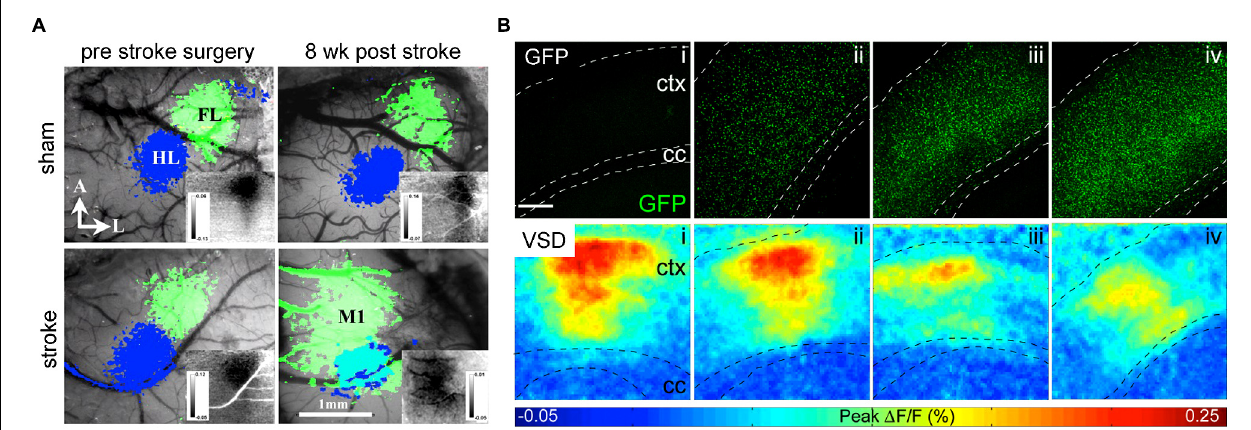
FIGURE 4 |VSD imaging detects macroscopic changes in functional networks after stroke and implantation of NSCs. (A) Changes of the functional representation of the forelimb (FL) cortex area toward the peri-infarct primary motor cortex M1 and hindlimb (HL) area appear 8 weeks upon photothrombotic stroke but not sham surgery. Reprinted by permission from MacMillan Publisher Ltd: Molecular Therapy (Brown